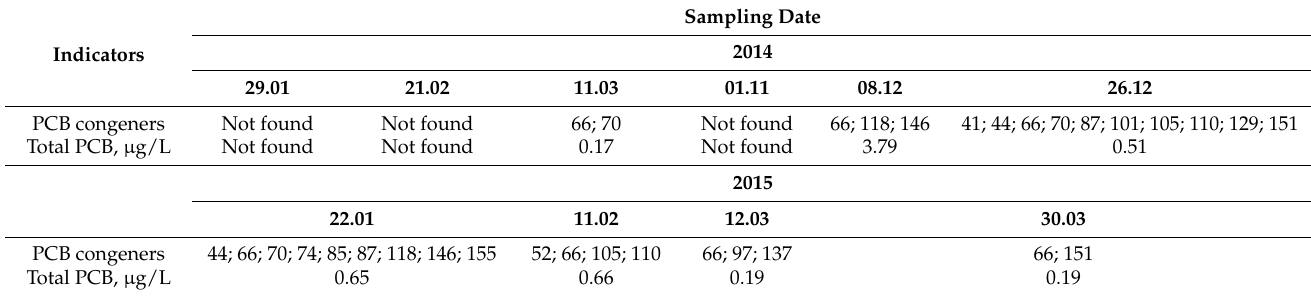
Table 2. Content and congener composition of PCBs in solid precipitation in the territory of Almaty city.